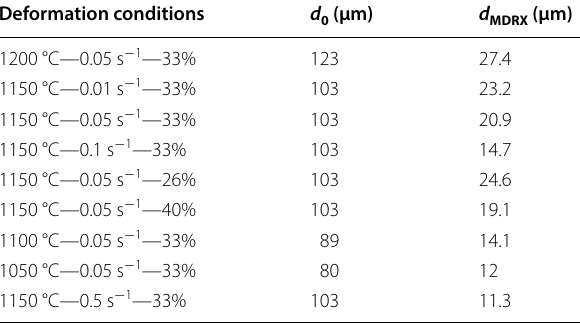
Table 4 Average grain sizes of